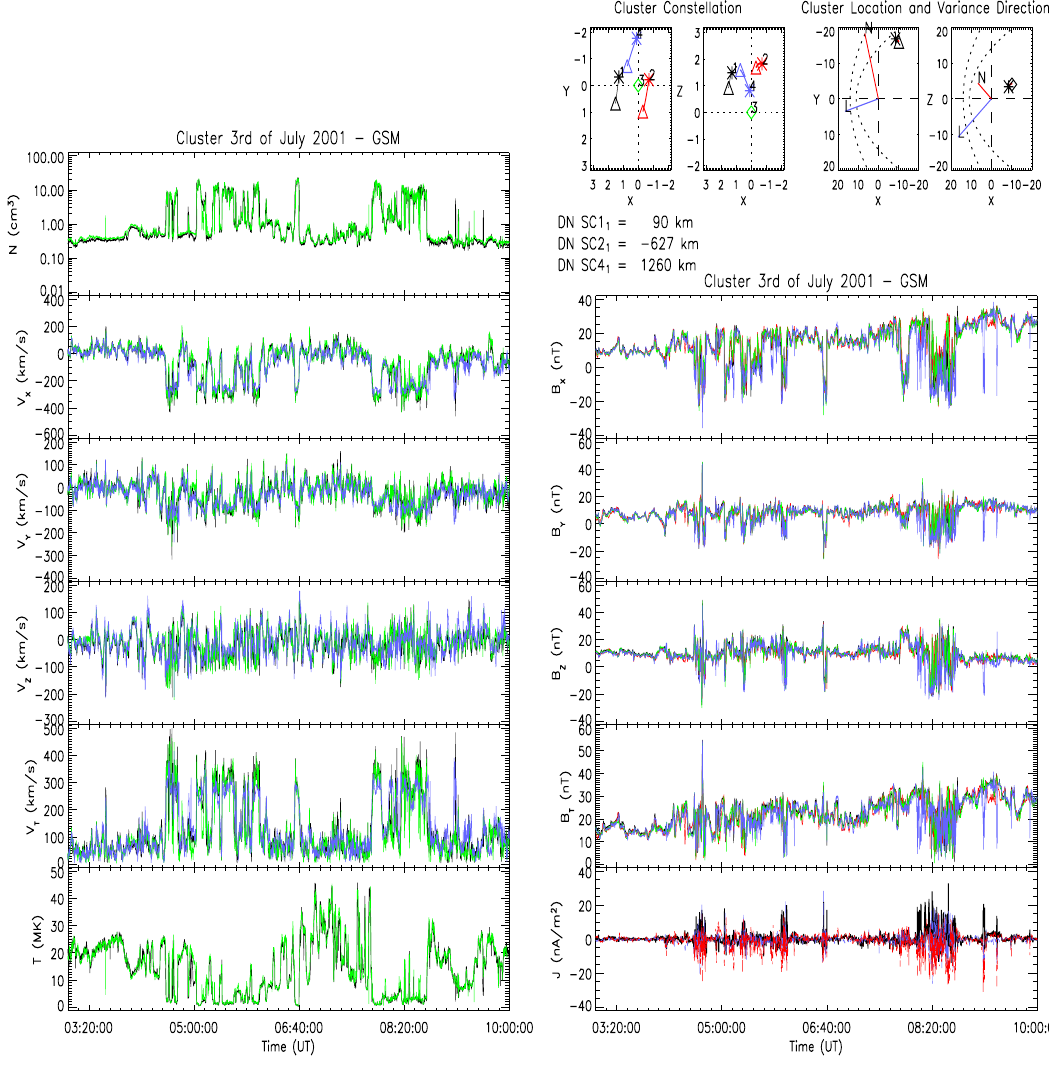
Fig. 4. Cluster plasma (left) and magnetic field observations (right) on 3 July 2001 between 03:20–10:00 UT. Black, red, green and blue colors represent sc1, sc2, sc3 and sc4 and their measurements, respectively. The first two panels in the upper right corner have Cluster constellation (asterisk marks the position at the beginning and diamond at the end of the interval) in x,y - and x,z -planes in GSM coordinates relative to sc3 (in units of 1000km/s). The last two panels in the upper right corner show Cluster location in x,y - and x,z -planes (GSM in units of R E ) with the approximate magnetopause and bow shock locations presented as parabolas. The boundary normal ( N ) and tangent ( L ) directions are shown as red and blue arrows (computed using sc1 data with MFR-method that is applied to the entire plotted interval), respectively. The plasma data shows from top to bottom ion density, three velocity components, total velocity and plasma temperature. On the right hand side the first four panels show the magnetic field components and magnitude and the lowest panel shows the three components of the current density (black, blue and red colors correspond to x -, y - and z -components,